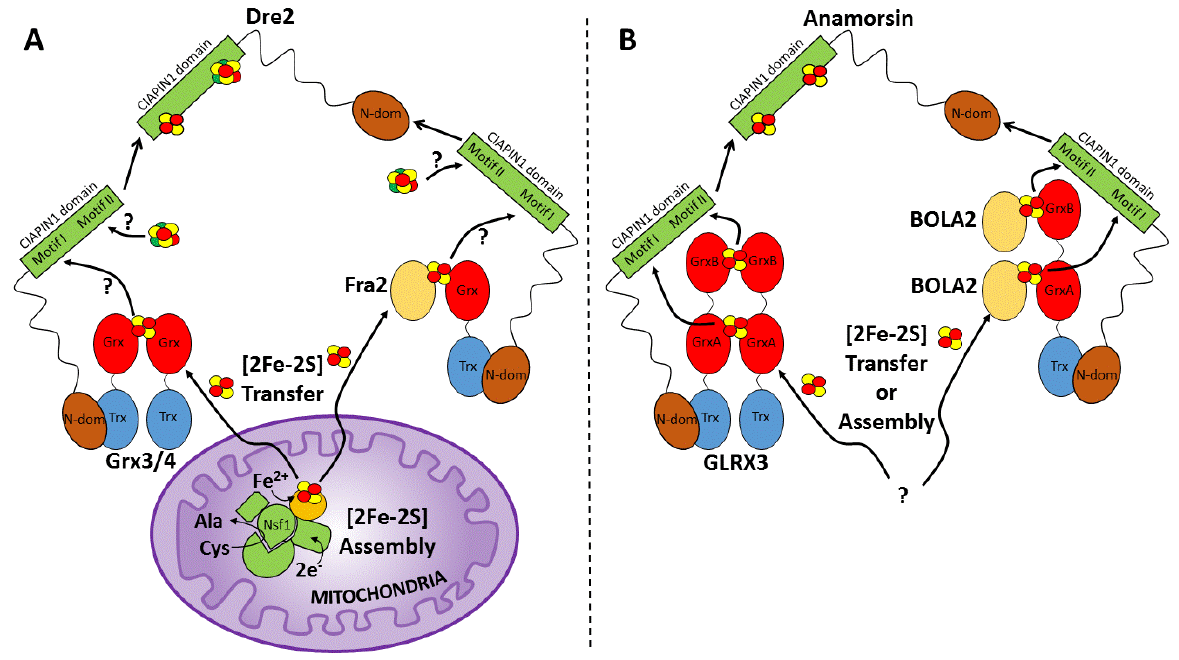
Figure 5. Model of Fe/S cluster insertion into Dre2 ( A ) and anamorsin ( B ). Red sphere is Fe(III) ion, green sphere is Fe(II) ion and yellow sphere is sulfide ion.